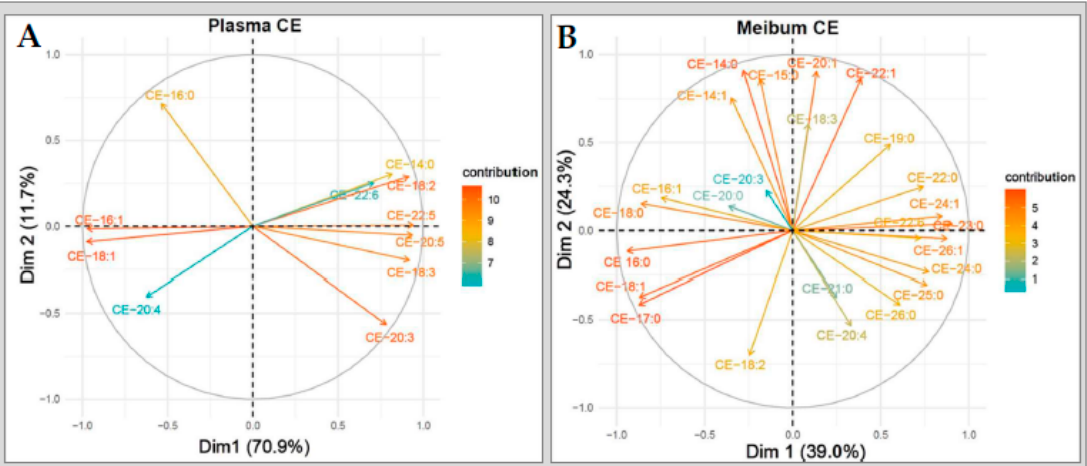
Figure 8. Variable correlation plots of ( A ) plasma CE and ( B ) meibum CE species.